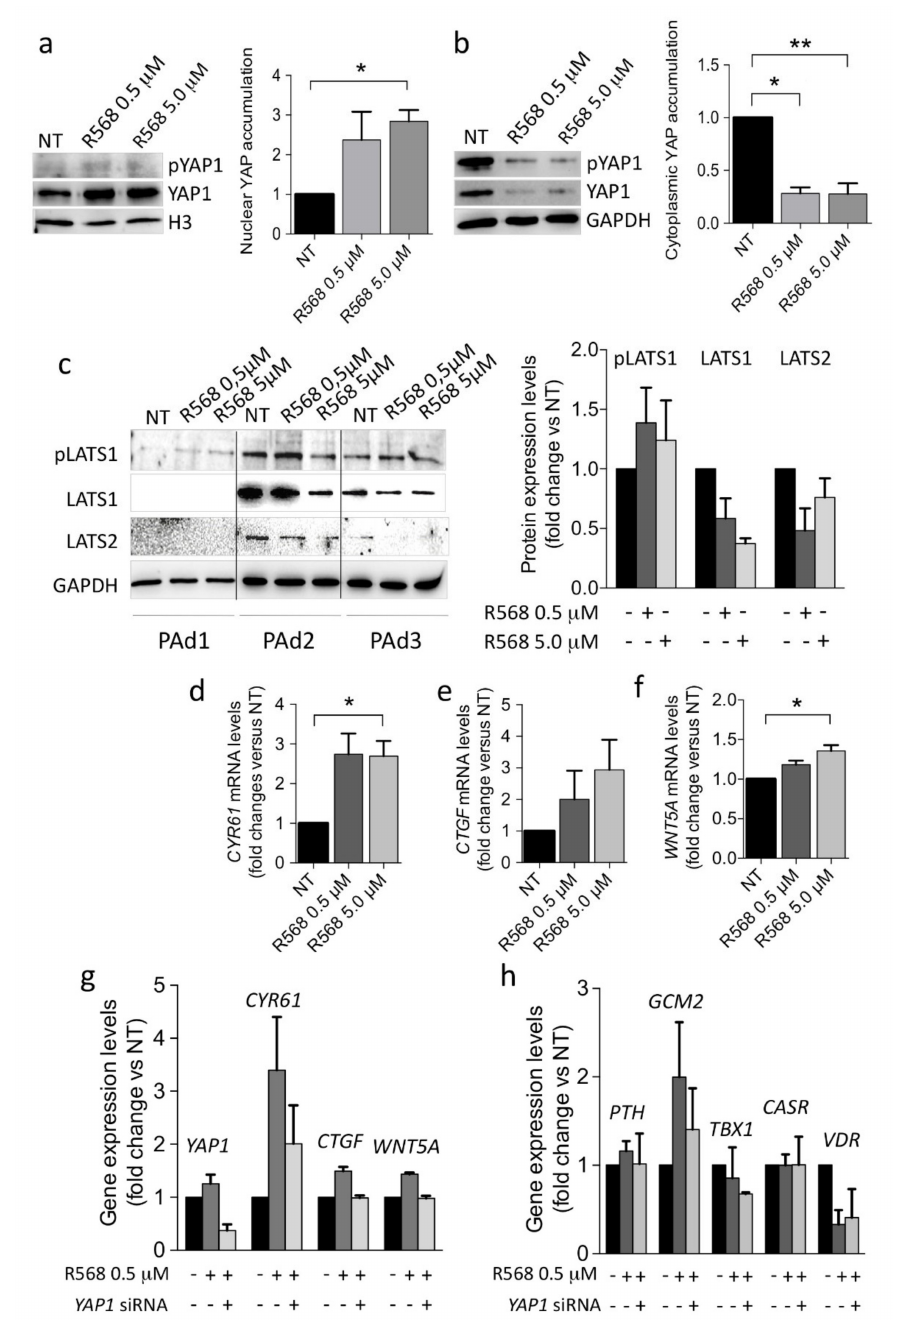
Figure 4. CASR activation induces YAP1 signaling in primary PAd cultures. ( a , b ) YAP1 nuclear accumulation ( a ) or cytoplasmic abundance ( b ) were investigated in primary PAd cultures ( n = 3) after stimulation for 1 h with the indicated concentrations of the CASR agonist R568 (* in panel a , p = 0.06; * in panel b , p = 0.018 in presence of 0.5 µ M, and ** in panel b , p = 0.037 in presence of 5.0 µ M); representative Western blots are shown with densitometric analyses (right panels). Bars, mean protein expression from three experiments relative to untreated cultures (NT) ± SEM. p -values are from one-way ANOVA. ( c ) Inhibition of the LATS1/2 protein levels in primary PAd-cultures ( n = 3) upon treatment with the CASR agonist R568. Western blot and relative densitometric analysis (right panel) are shown. ( d − f ) Analysis by qPCR of the indicated YAP1-target genes expression in three primary PAds-derived cultures treated with R568 (* p = 0.037 in panel d ; * p = 0.210 in panel e , and * p = 0.035 in panel f ) by qPCR in 3 PAds-derived cell preparations. ( g , h ) The expression of the YAP1-targeted genes CYR61 , CTGF , and WNT5A or of the key parathyroid genes PTH , GCM2 , TBX1 , CASR , and VDR was analyzed in primary PAds-cultures transiently silenced for YAP1 and treated with the CASR agonist R568. Data are expressed relative to untreated (black bars). Bars, mean gene expression from two experiments ±